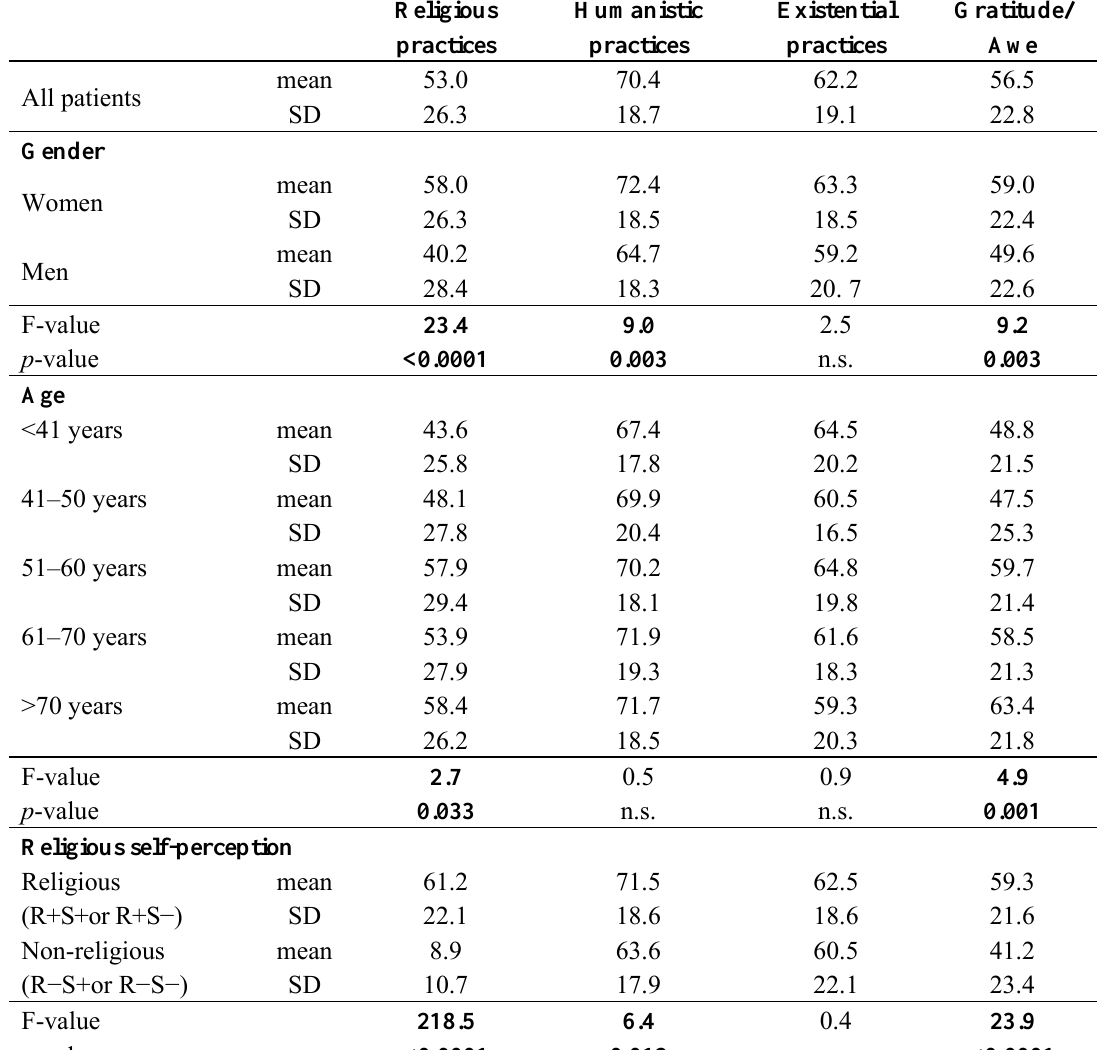
Table 4. Mean values of SpREUK-P factors with respect to